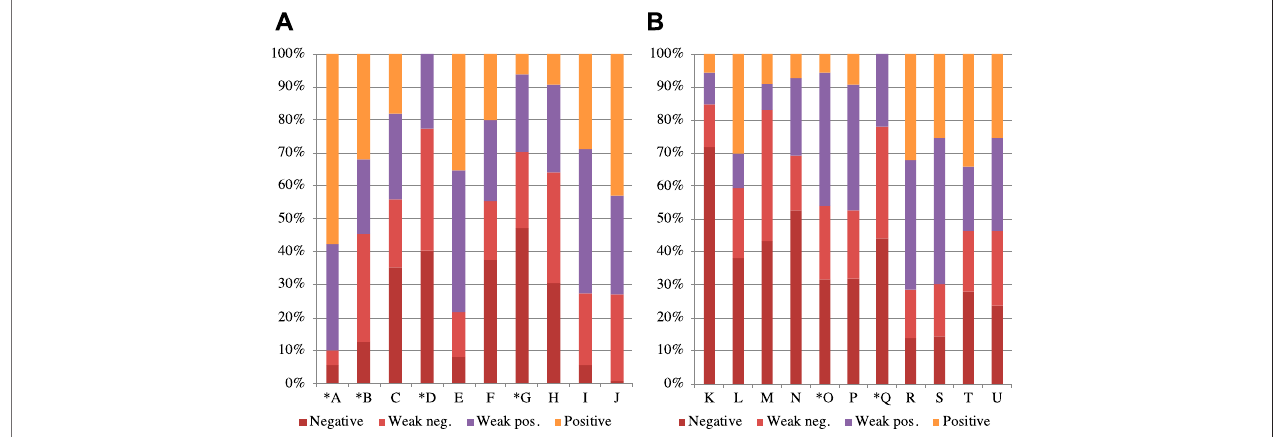
FIGURE 5 | Ratio of robot ’ s emotional state during interaction in the (A) face group and the (B) no-face group. Letters indicate each participant. * shows participants who refused the robot. The alphabets denote the participant IDs.